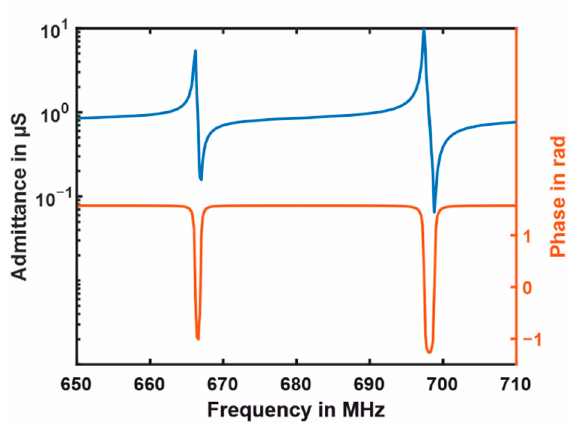
Figure 12. Current amplitude in the magnitude and phase of the co-resonant vibration system.